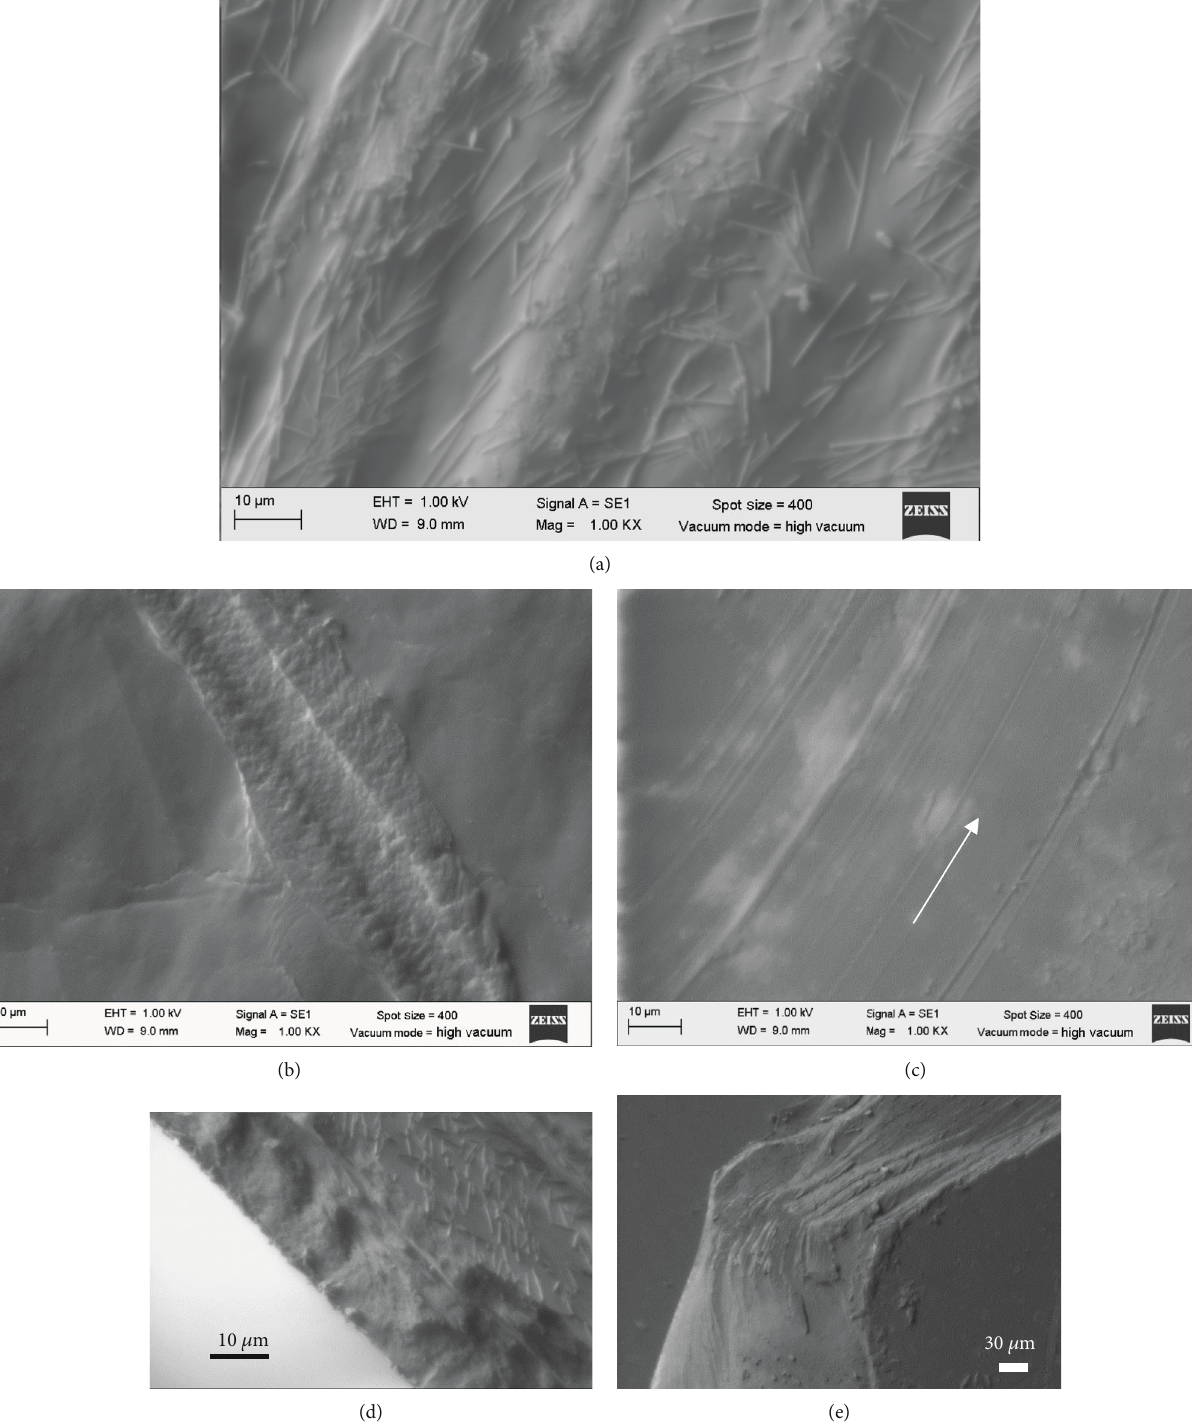
Figure 9: SEM micrograph of CNC fi lms: (a) pure CNC fi lm, (b) CNC fi lm with glycerol, (c) 5wt% CNC fi lm, (d) lateral view of pure CNC fi lm, and (e) lateral view of 5wt% CNC fi